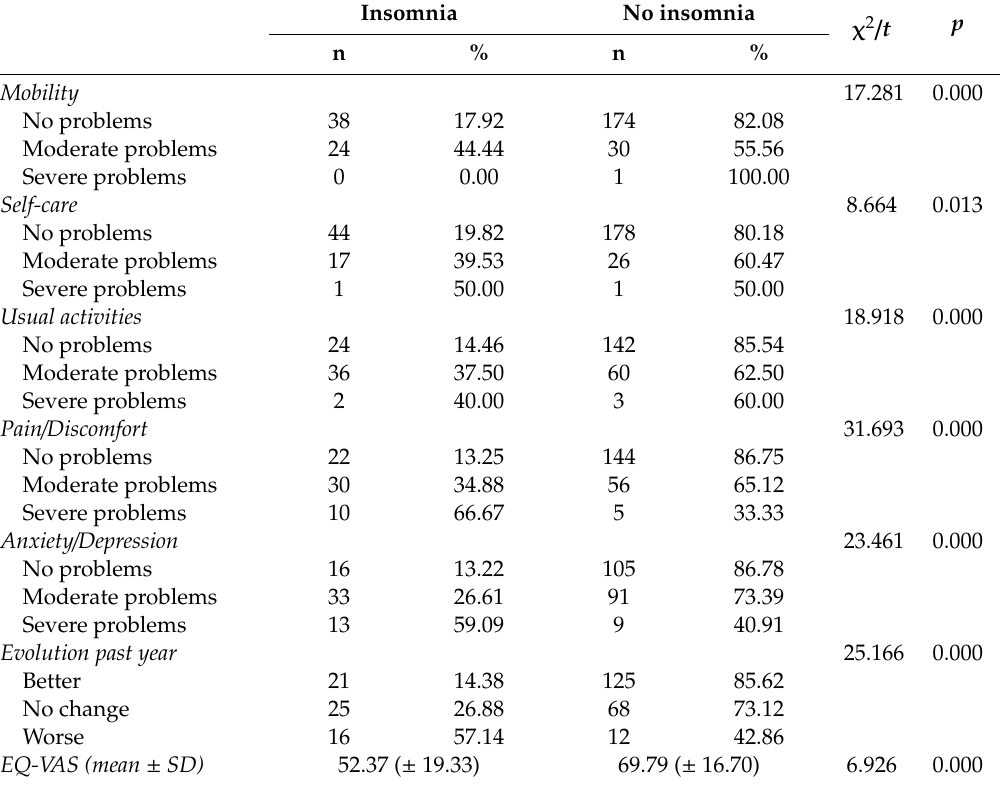
Table 2. EuroQol-5D Scale (EQ-5D) dimensions according to presence / absence of insomnia